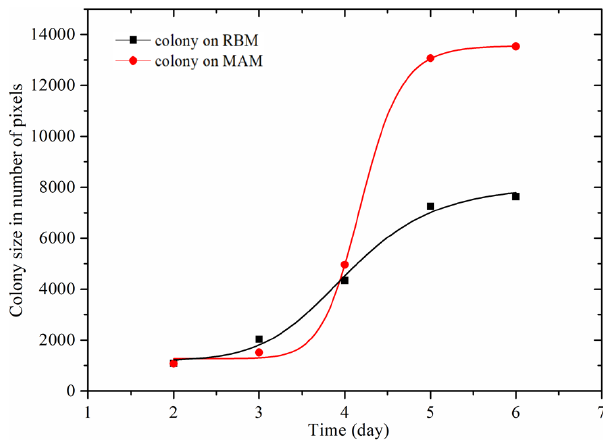
Fig. 3. Growth curves of